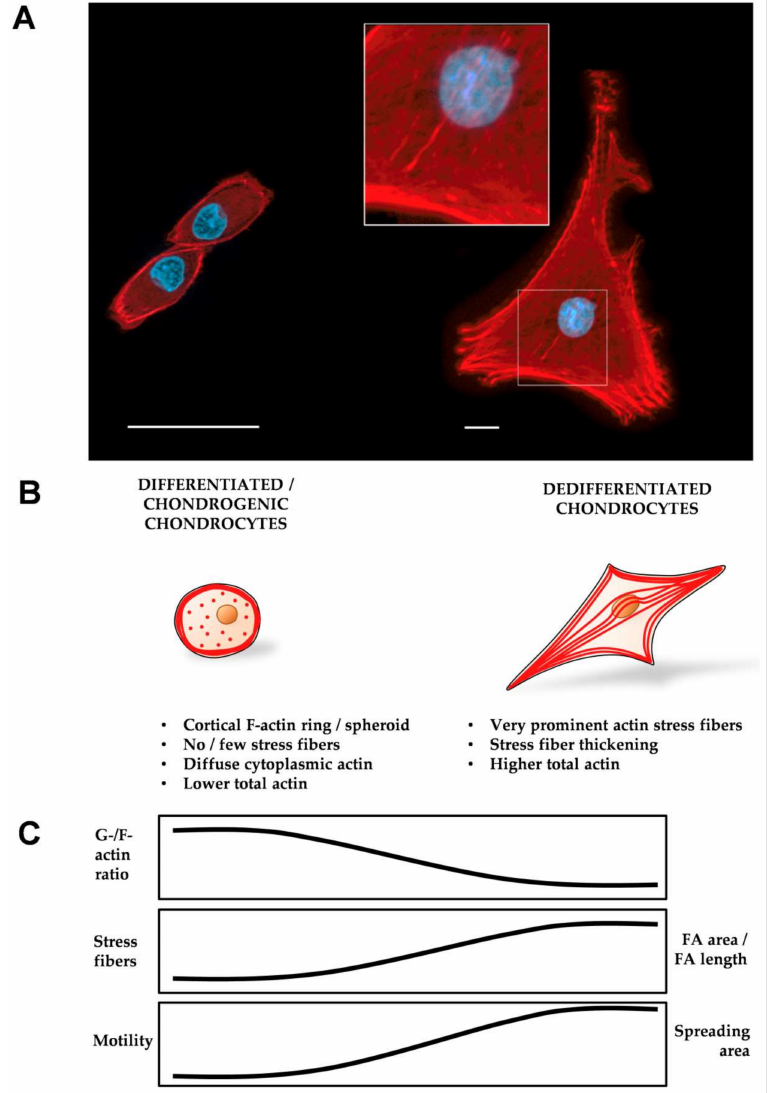
Figure 3. ( A ) Representative 40x images of primary hCHs with different morphologies and the F-actin distribution on day 1 of cultivation, acquired with an AxioObserver-Z1, Zeiss, Germany. Left side: CHs cultured on a glass substrate coated with fibronectin. The image was taken with oil immersion. Right side: a CH cultured on a tissue culture polystyrene substrate. Red: F-actin, blue: nucleus. Scale bar: 50 µ m. ( B ) Schematic actin organization, FA area, spreading area, and motility related to the CH differentiation status. Differentiated and round CHs have a cortical F-actin